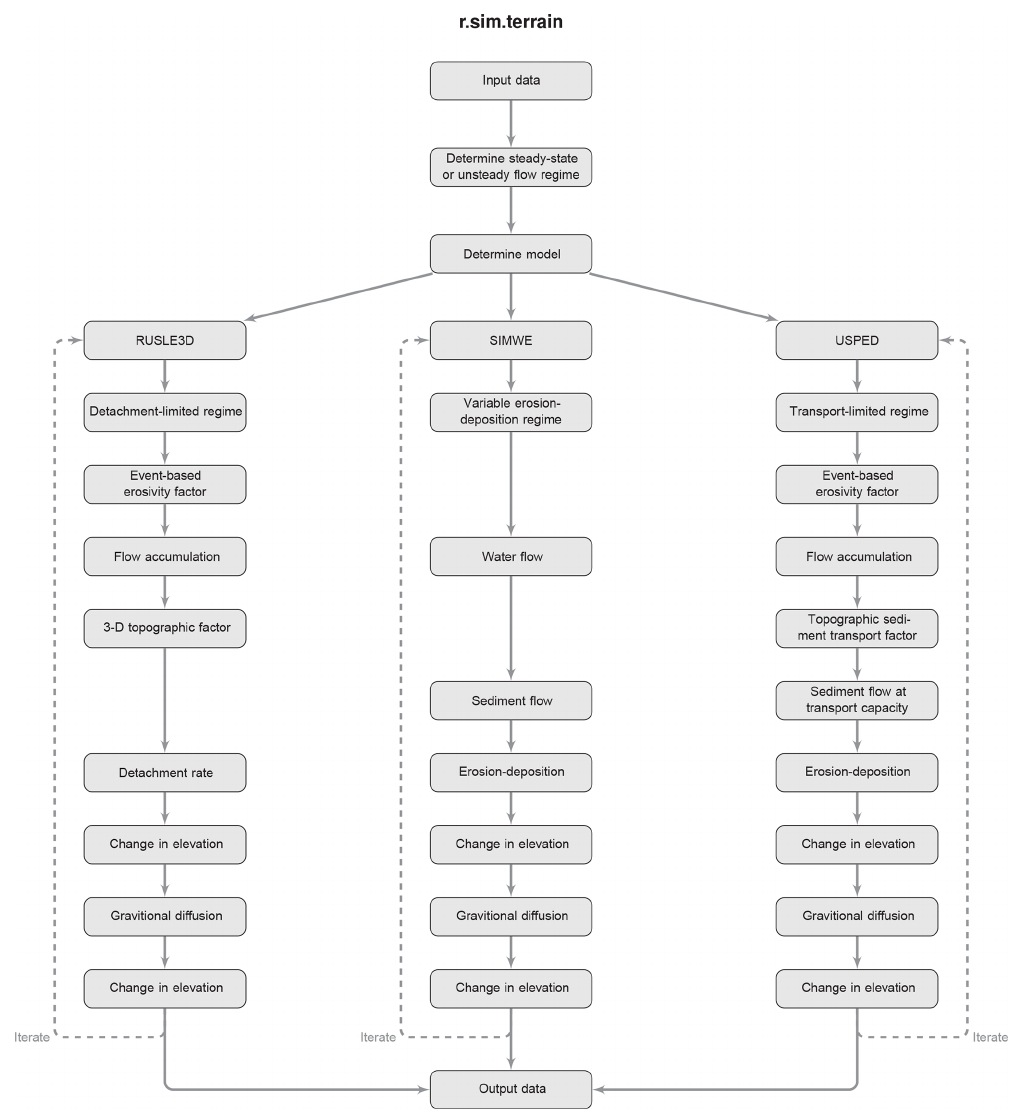
Figure 2. Conceptual diagram for